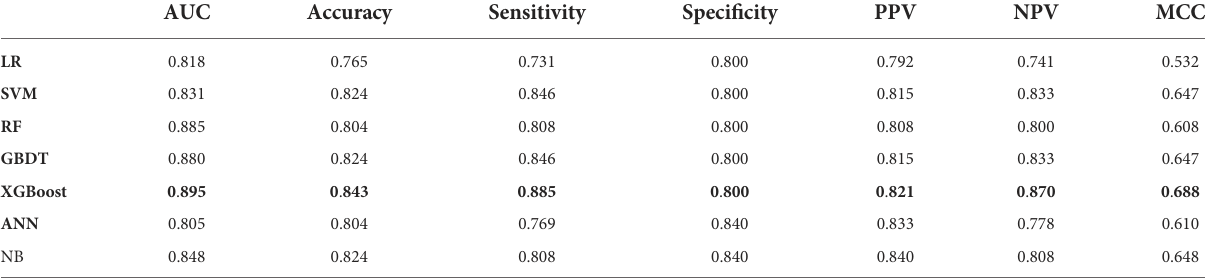
TABLE 2 Prediction performance of the machine learning models in the test set.